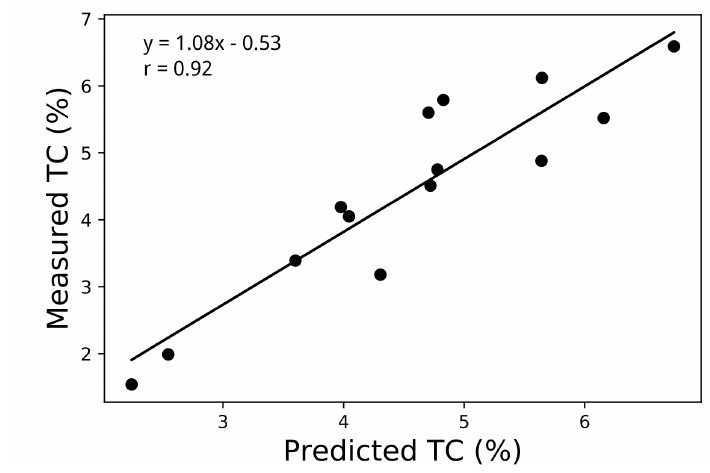
Figure 8. Linear regression applied to predicted and measured